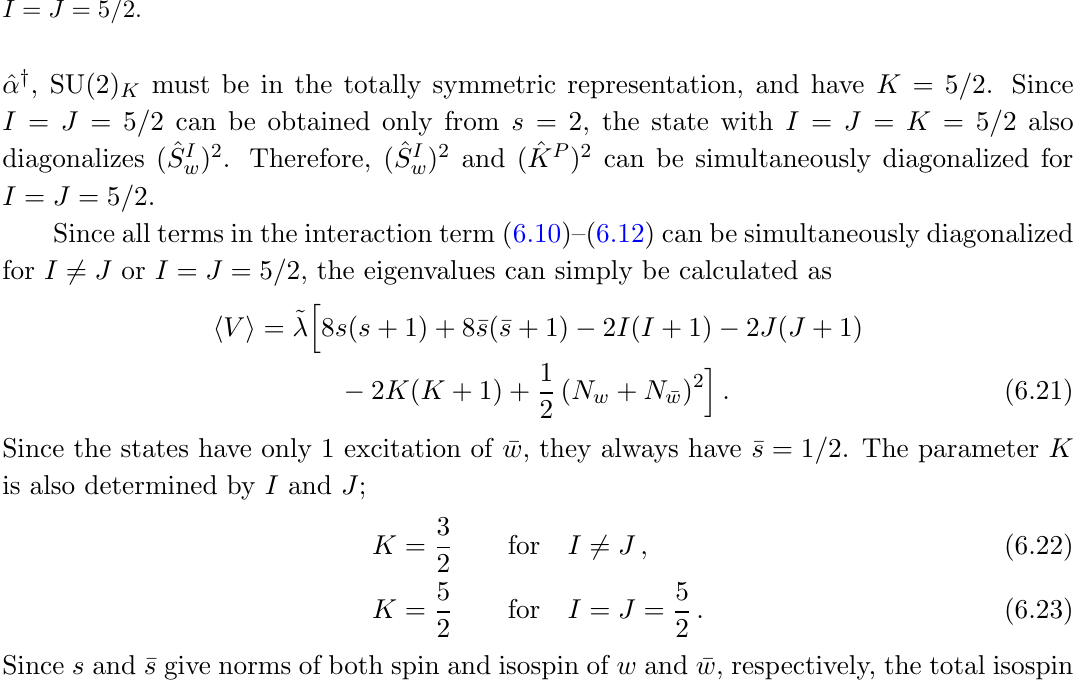
Table 8 . The eigenvalues of V for the excited states with N X = 0, N w = 4, N (cid:22) w = 1, and I 6 = J or I = J = 5 =